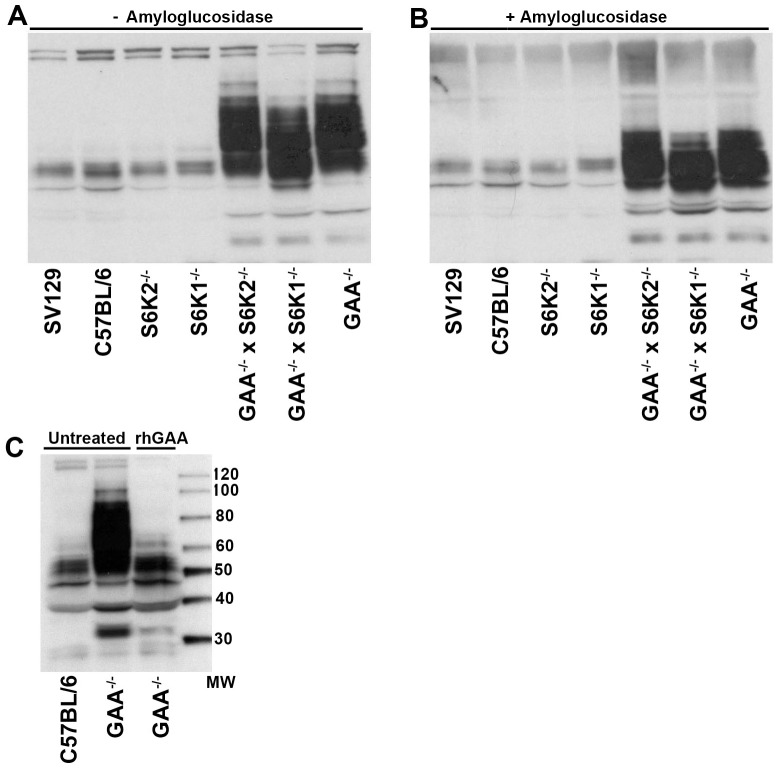
Glycogenin levels are dysregulated in GAA−/− mice and normalized by rhGAA treatment.Homogenates from triceps were prepared for the indicated strains. Lysates from 5 mice for each strain were pooled and 100 µg of protein analyzed by Western blot. A monoclonal antibody to glycogenin was used to probe the blots. (A) lysates not treated with amyloglucosidase. (B), treated with amyloglucosidase. (C) GAA−/− mice were dosed with rhGAA as described in the legend for Figure 4. Lysates from the strains indicated in this panel were not treated with amyloglucosidase.